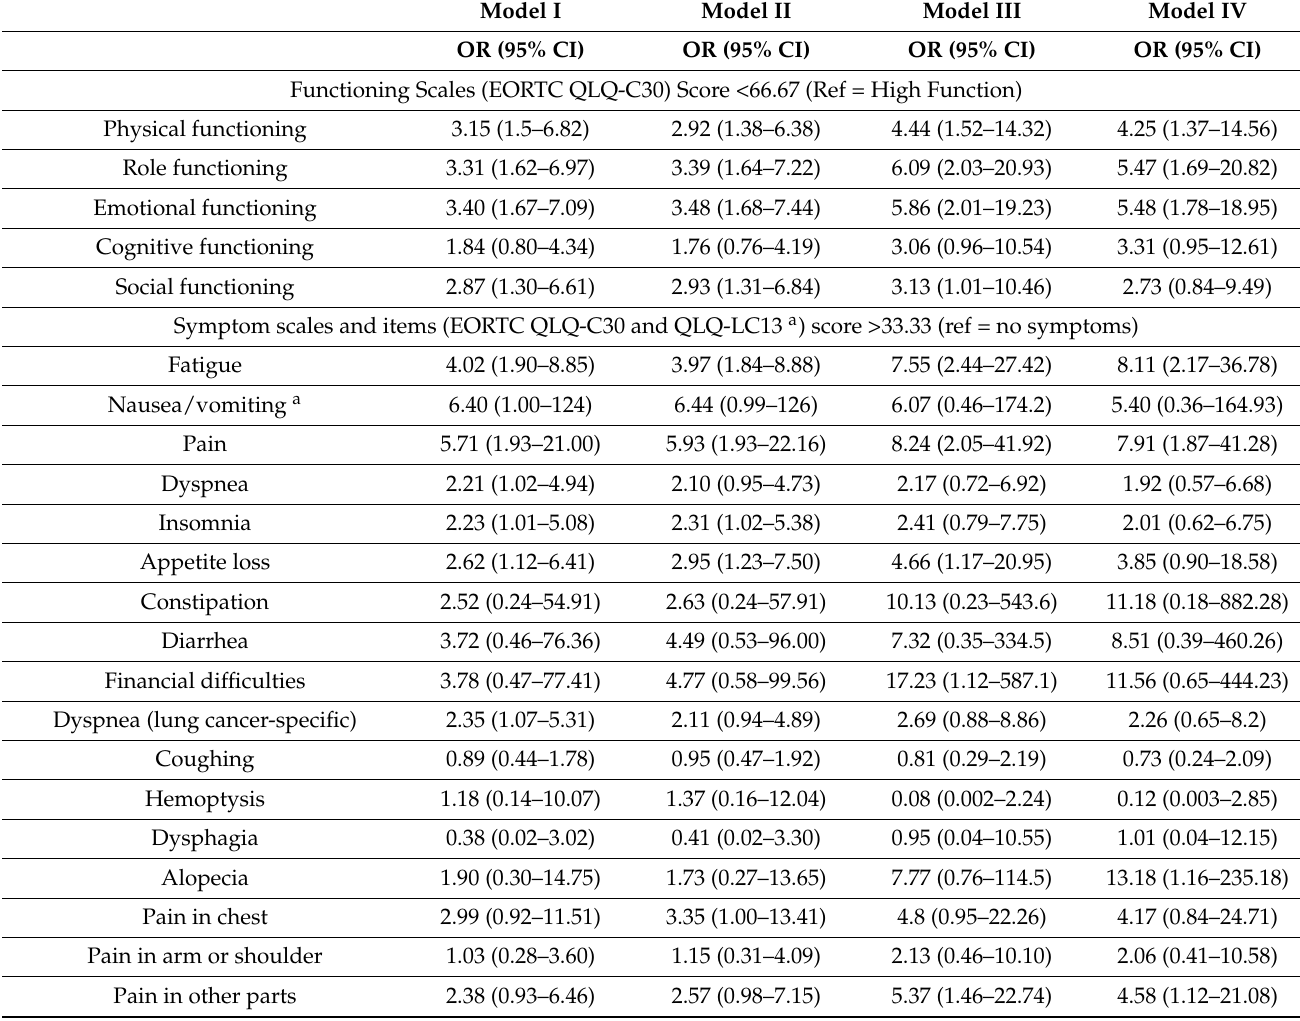
Table 3. Logistic regression for the association between pretreatment quality of life and not completing first-line treatment among 137 lung patients, Herlev University Hospital, Denmark,